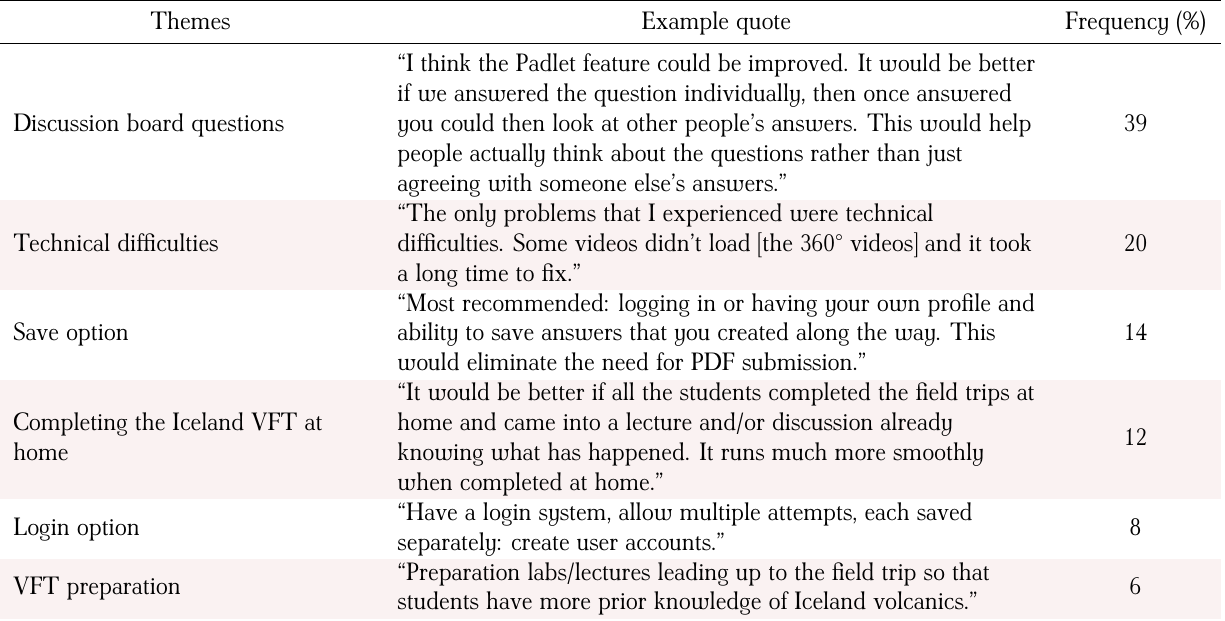
Table 3: The themes, relevant quotes, and frequency count of student answers to Q3 of the evaluation